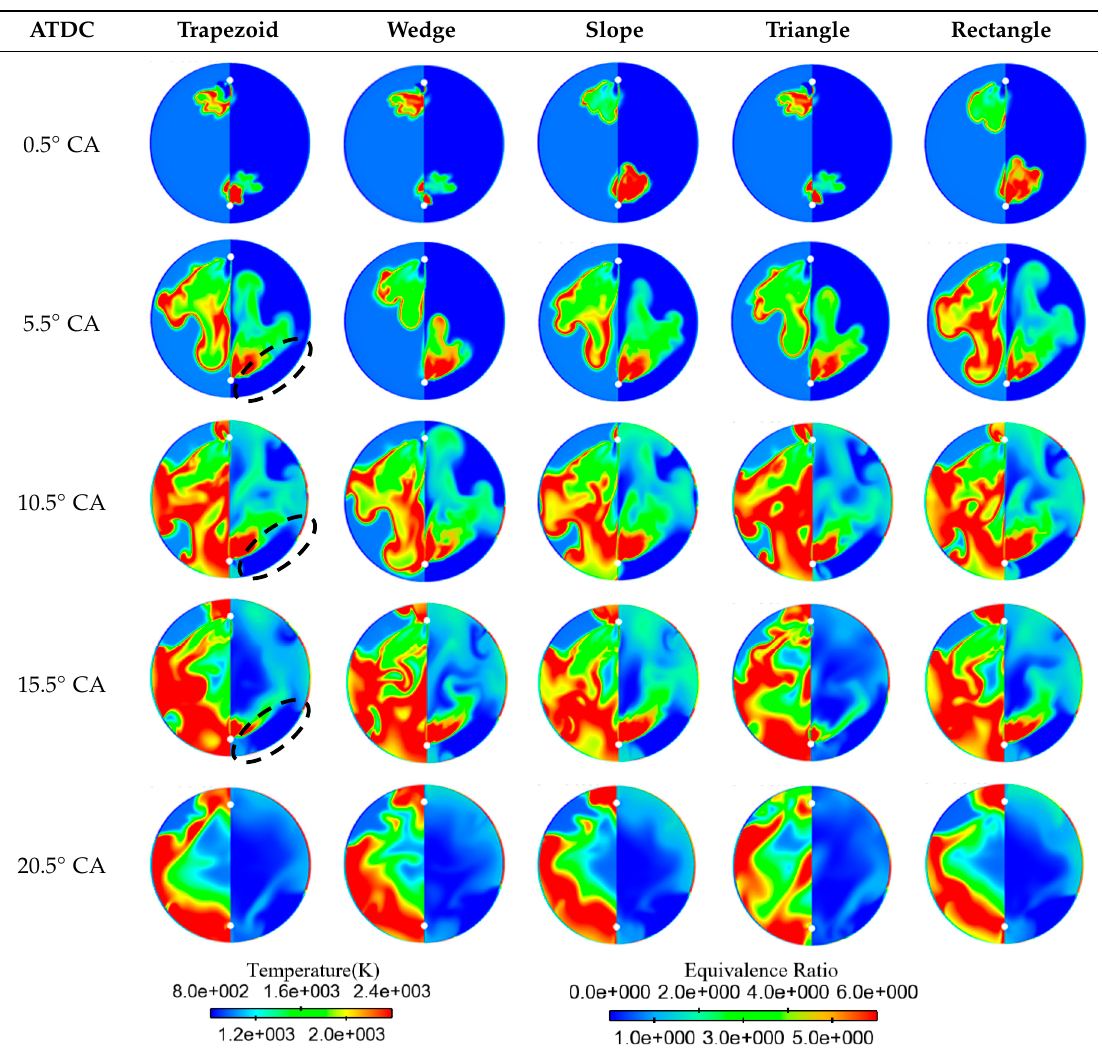
Table 4. The in-cylinder temperature (left) and equivalent ratio (right) distributions for different gas injection rate shapes.